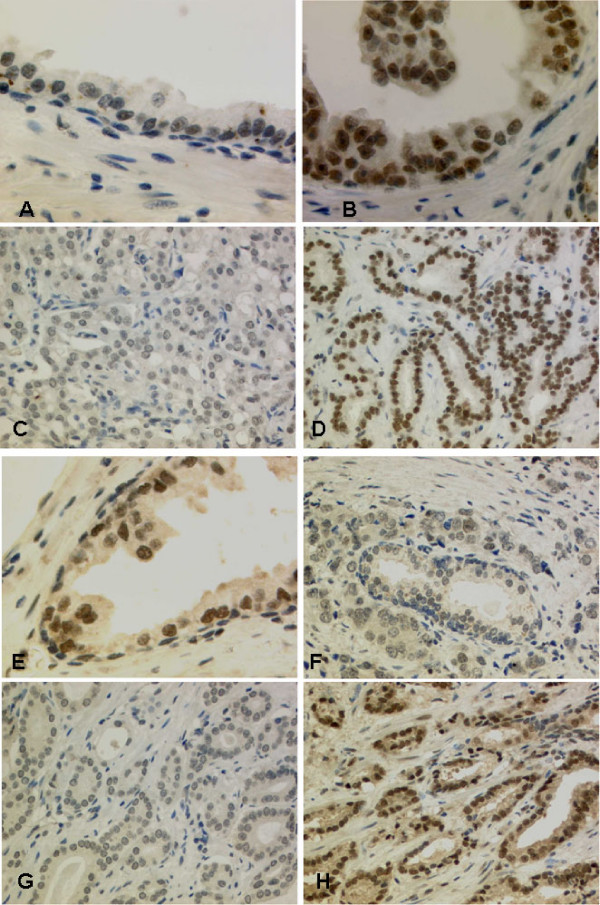
Expression of FBP1 and FBP3 in normal prostate and prostate cancer. A) Normal prostatic epithelium with a strong nuclear expression of FBP1, basal cells are mostly devoid of FBP1 expression (40×). B) Prostatic intraepithelial neoplasia (PIN) also shows a strong nuclear signal for FBP1 (40×). C) Prostate cancer with weak FBP1 expression (20×). D) Prostate cancer with strong FBP1 expression (20×). E) Normal prostatic epithelium also reveals a strong nuclear expression of FBP3, basal cells are again mostly negative for FBP3 (40×). F) Normal gland (central), surrounded by invasive carcinoma with equal FBP3 expression (20×). G) Prostate cancer with low FBP3 expression (20×). H) Prostate cancer with high FBP3 expression (20×).